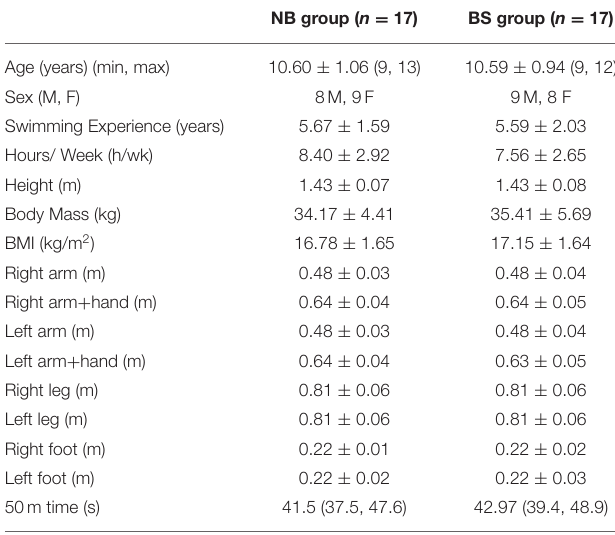
TABLE 1 | Participants’ characteristics of No Breath (NB) and Breath Stroke (BS)